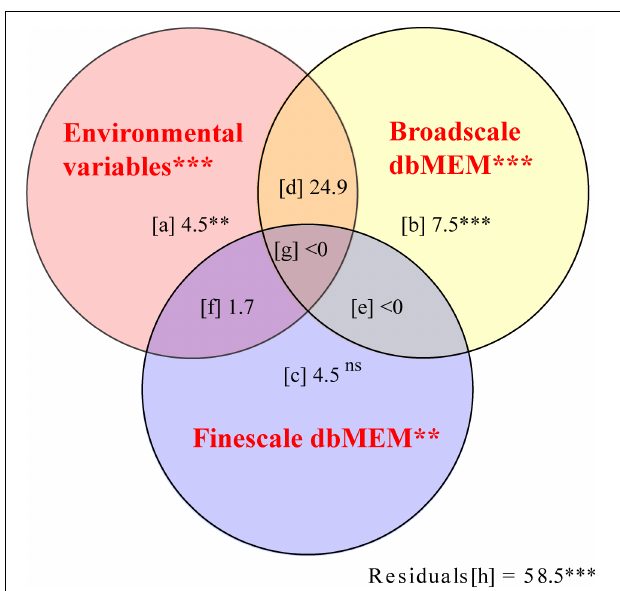
FIGURE 5 | RDA ordinations of bryophyte species with environmental variables. Bryophytes (red + ): Apa, Aulacomnium palustre ; Aun, Atrichum undulatum ; Ccu, Calliergonella cuspidata ; Cst, Campylium stellatum ; Sfl, Sphagnum flexuosum ; Sim, S. imbricatum ; Ssu, S. subsecundum ; Swa, S. warnstorfii . Environmental variables (blue arrows): altitude (Alt), calcium (Ca), phosphorus (P), potassium (K), sodium (Na), and water table depth (WTD).